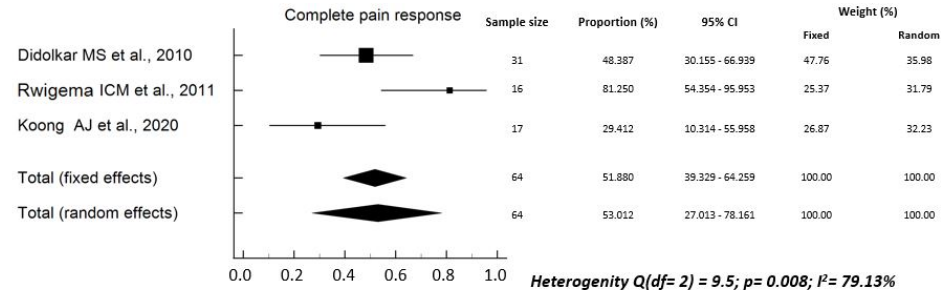
Figure 3. Overall complete response to pain [18,21,34].